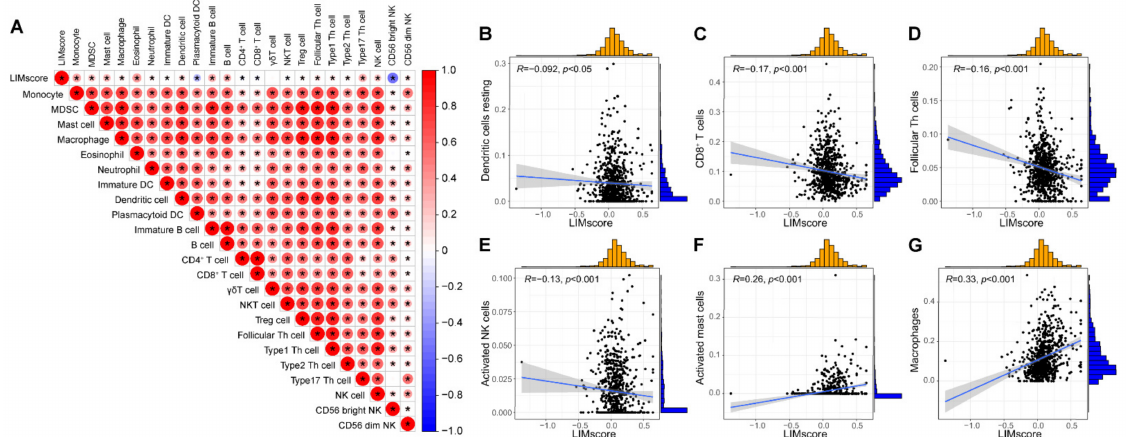
Figure 4. The LIMscore correlated with immune cell infiltration. ( A ) Correlations between LIMscore and immune cells. The LIMscore was negatively associated with the abundance of resting dendritic cells ( B ), CD8 + T cells ( C ), follicular helper T cells ( D ), and activated NK cells ( E ), albeit positively associated with activated mast cells ( F ) and macrophages ( G ). * p <